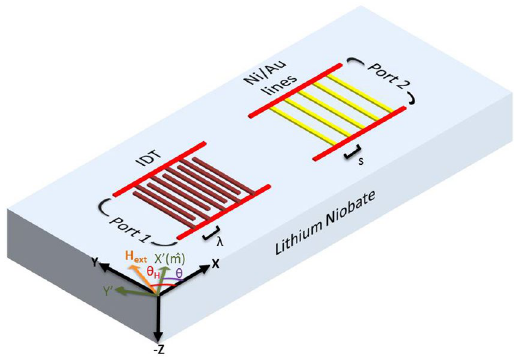
Figure 1. The schematic of the device. Ni/Au lines are on one side and IDT is on another side. The periodicity of the Ni/Au lines s was either λ or 0.5 λ . The Ni lines undergo FMR and generate SAW which can be detected by the IDT at the other side.